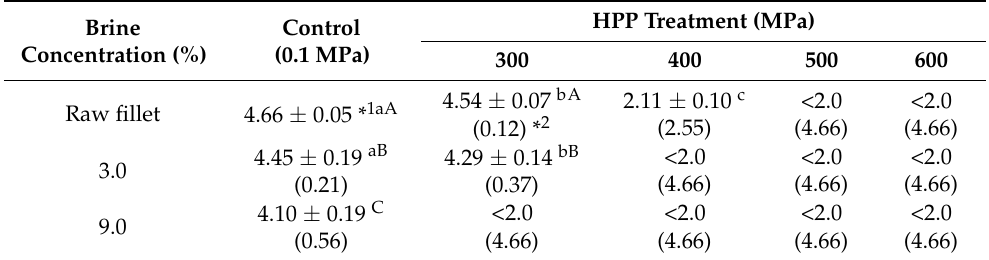
* 1 Data are average ± standard deviation for triplicate. Averages in every row with the different lowercase letter are significantly different ( p < 0.05). Averages in every column with the different uppercase letter are significantly different ( p < 0.05). * 2 : Reductions in bacterial populations (log CFU/g) after treatments as compared with raw fillet. Table 2. The psychrotrophic bacteria count of mackerel fillets after the brine salting of 3.0% and 9.0% for 90 min at 4 ◦ C, and then pressurization at 300, 400, 500, and 600 MPa for 5